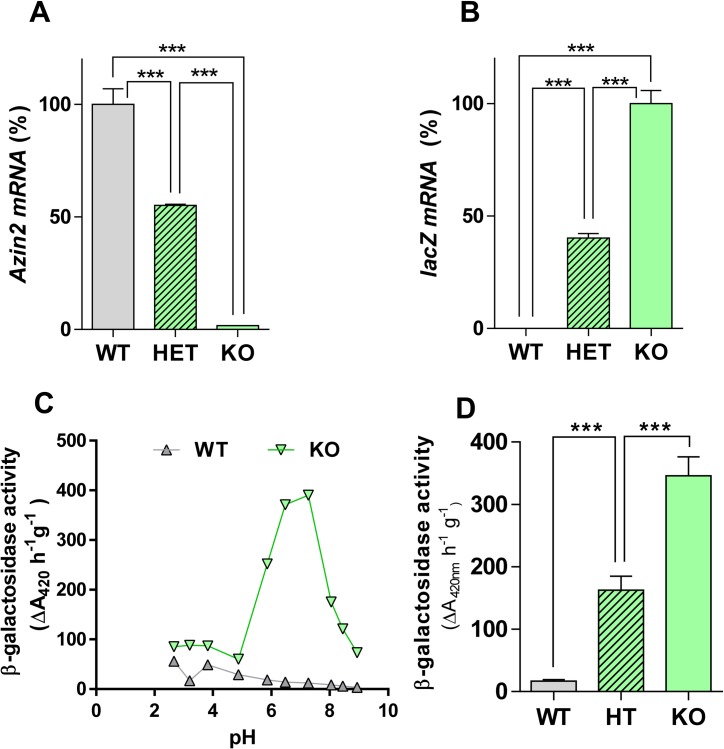
Expression of Azin2 (A), and Azin2-lacZ (B) in the testis of wild type (Azin2
+/+, WT), heterozygous (Azin2
+/βGeo, HET) or Azin2 knock-out (Azin2
βGeo/βGeo, KO) adult mice. (C) Influence of pH on testicular β-D-galactosidase activity. (D) Neutral (pH = 7.2) β-D-galactosidase activity in the testis of WT, HET and KO adult mice. For the analysis of Azin2 mRNA levels a pair of primers amplifying exons 8 and 9 were used, and for lacZ the primers used amplified a segment of the bacterial enzyme. In A and B the values are expressed as mean±SEM of 3 animals per group. In C and D, β-D-galactosidase activity from testis homogenates is expressed as ΔA420 per h and g of wet tissue (means of triplicate determinations). Statistical significance was determined by one-way analysis of variance (ANOVA) followed by Tukey’s multiple comparison test. *** P<0.001.